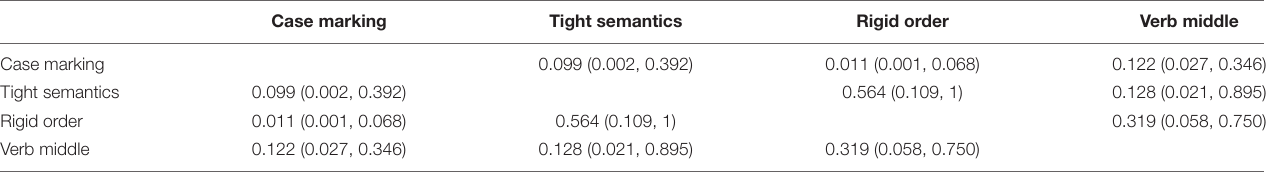
TABLE 6 | Mean p -values of the edges in